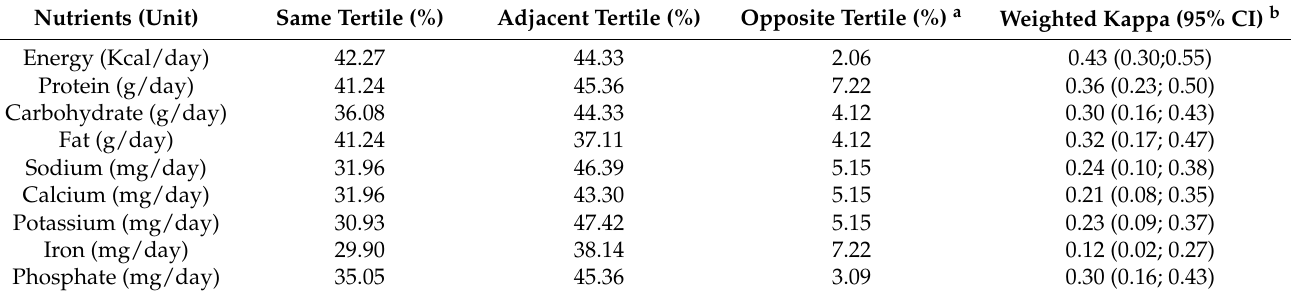
Table 7. Limit of agreement (LoA) and correlation between mean and mean differences.